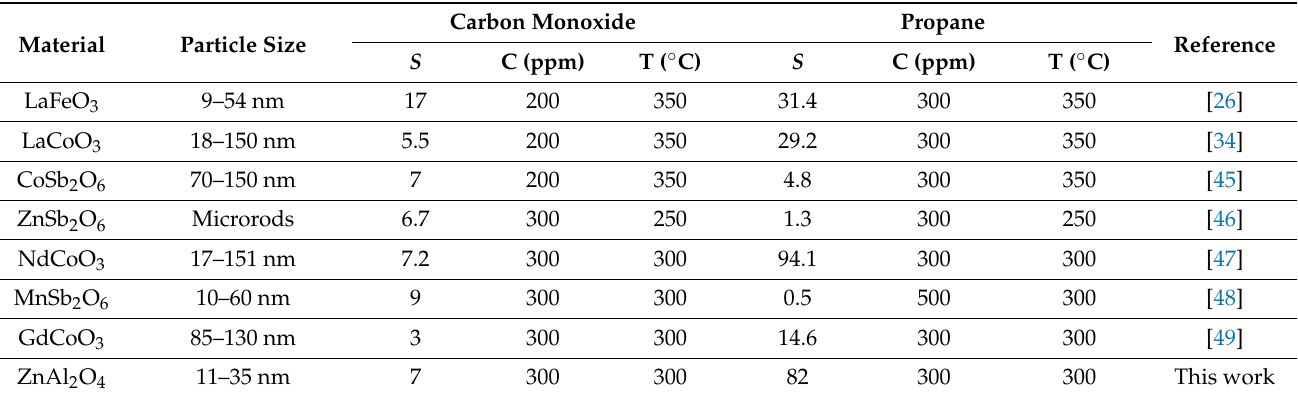
Table 3. Gas sensitivity (S) of several